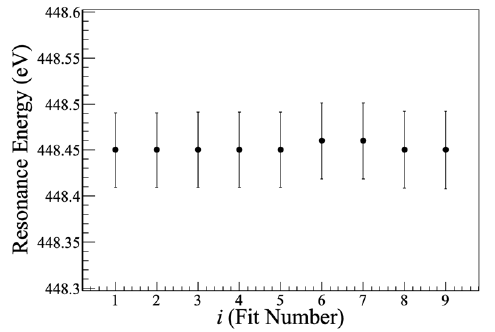
Figure 7. Resonance energy of resonance No. 4 using each sam- ple thickness. The fit number represents which sample thickness was used in fitting such as n t − 4 ∆ n t for i = 1.